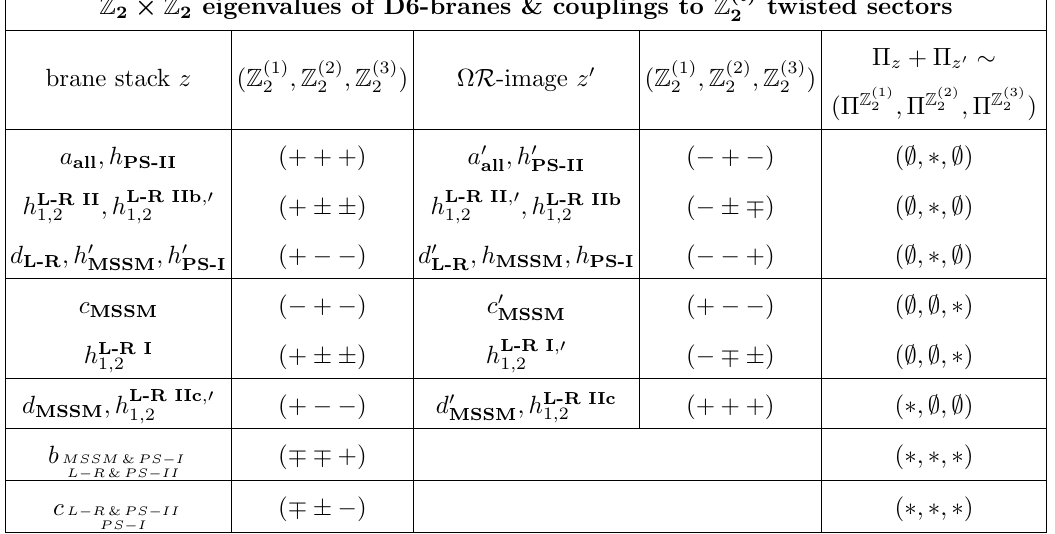
Table 10 . Z 2 (cid:2) Z 2 eigenvalues of D6-brane stacks z and their orientifold images z 0 in the phe- nomenologically appealing MSSM, L-R symmetric and PS models with D6-brane con(cid:12)gurations displayed in tables 16, 18 and 21 & 23, respectively, together with the dependence of gauge cou- plings in equation (3.3) on twisted sectors, e.g. via (cid:5) a